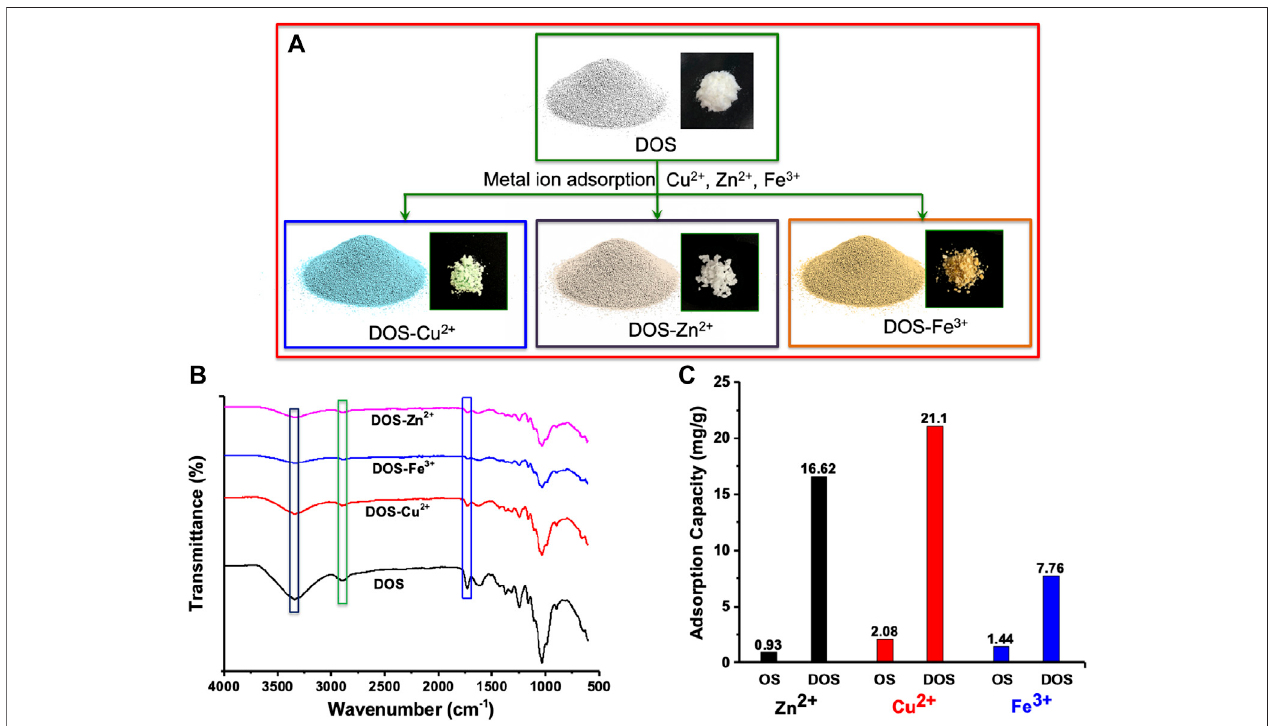
FIGURE3 |(A) illustrates colorchange of deligni fi ed olive stone powder after differences inmetal ionadsorption. (B) FTIR spectra ofdeligni fi ed olive stonepowder after adsorption of Fe 3+ , Cu 2+ , and Zn 2+ . (C) metal ion absorption of original olive stone powder (OS) and deligni fi ed olive stone powder (DOS) for different metal